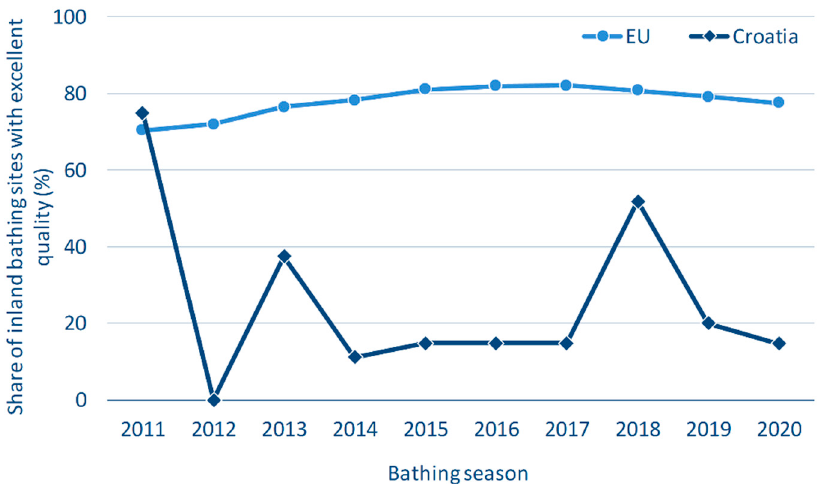
Figure 3. The share of inland bathing waters with excellent water quality in HR and the EU during the period 2011–2020.